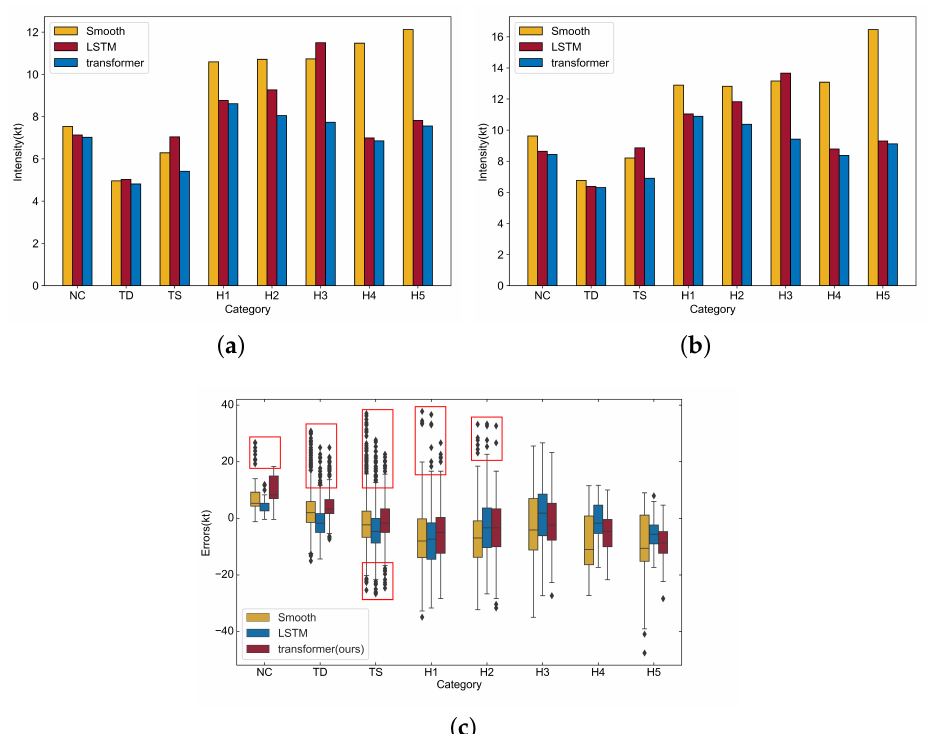
Figure 5. ( a , b ) are the comparison of MAE, RMSE respectively. And (c) is the box plot of estimated errors. The MAE and RMSE comparisons of the smooth procedure, LSTM, and transformer are shown in ( a , b ). The box plot of estimated errors of these three methods is shown in ( c ). In ( c ), we use a red rectangle to mark some outliers and we can see that our transformer has fewer outliers than other